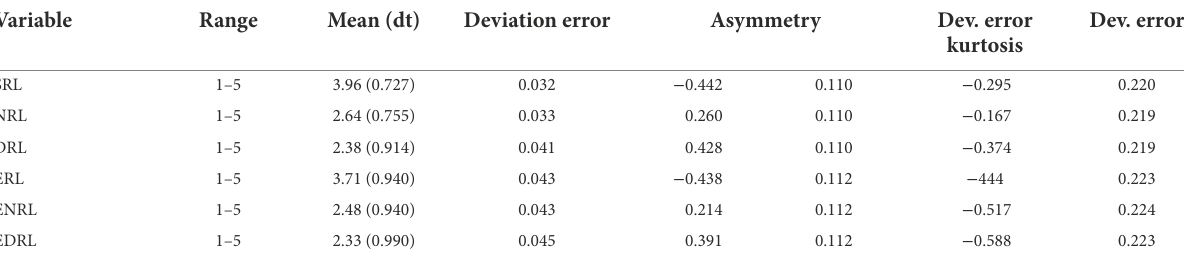
TABLE 13 Values descriptive for the validation sample ( n = 360).